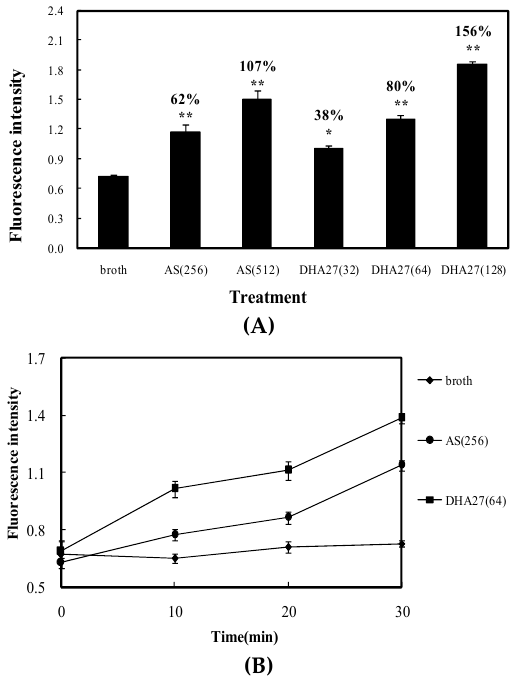
Figure 5. Effect of DHA27 on daunorubicin accumulation within E. coli ATCC 35218. Daunorubicin accumulation within E. coli ATCC 35218 pretreated with artesunate (AS) and DHA27. ( A ) E. coli ATCC 35218 was treated with artesunate (AS 256, 512 mg/L) and DHA27 (32, 64, and 128 mg/L) and cultivated at 37 °C and 100 rpm for 6 h, and then harvested by centrifugation at 4000 rpm for 5 min. After washing three times and resuspending, the bacterial suspension was adjusted to OD 600 1.0. Bacteria were incubated with daunorubicin (40 mg/L) in the dark at 37 °C for 30 min. The numerical values on the column were increased percentage of treatment group than broth group; ( B ) E. coli ATCC 35218 was treated with artesunate (AS, 256 mg/L) and DHA27 (64 mg/L) and cultivated at 37 °C and 100 rpm for 6 h, and then harvested by centrifugation at 4000 rpm for 5 min. After washing three times and resuspending, the bacterial suspension was adjusted to OD 600 1.0. Bacteria were incubated with daunorubicin (40 mg/L) in the dark at 37 °C for 0, 10, 20, and 30 min. Then, 0.5 mL of bacteria was collected. Bacteria were washed three times and resuspended in PBS. Quantitative determination of daunorubicin accumulation in the presence of AS and DHA27 was determined by fluorospectrophotometry at the emission wavelength of 467 nm and excitation wavelength of 588 nm.* p < 0.05 compared with broth, ** p < 0.01 compared with broth.